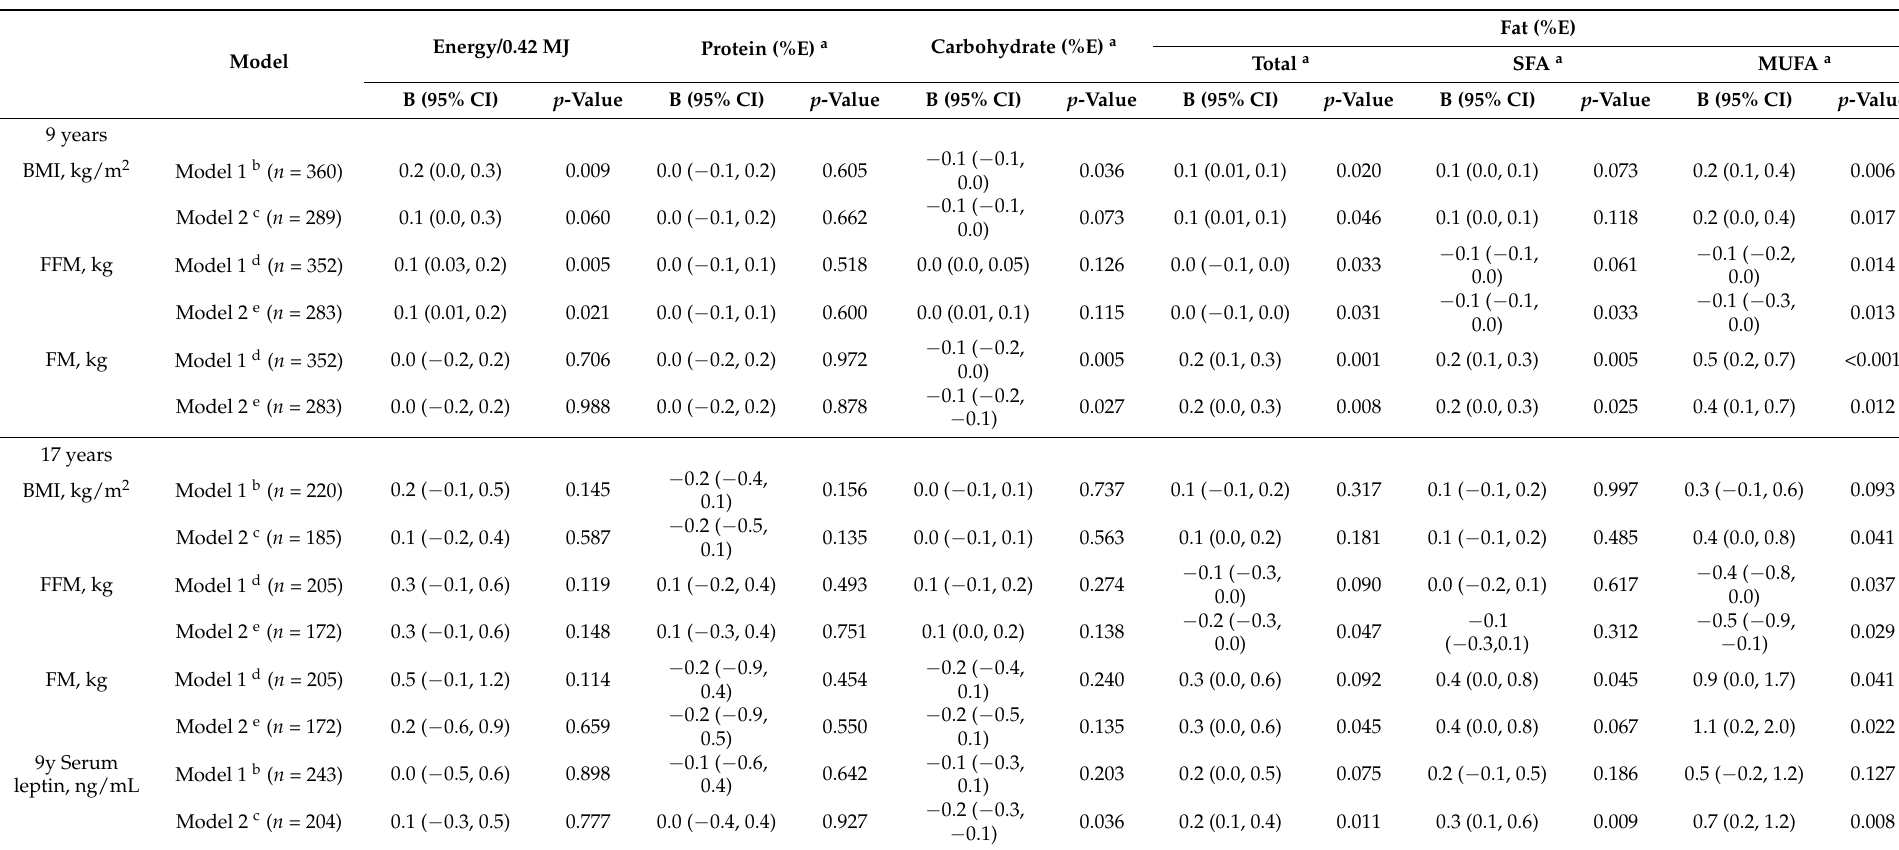
Table 2. Multiple linear regression models for energy and energy-adjusted macronutrient intakes of boys, using diet collected at 18 months of age to predict body composition and serum leptin concentration at 9 years of age and body composition at 17 years of age in children enrolled in